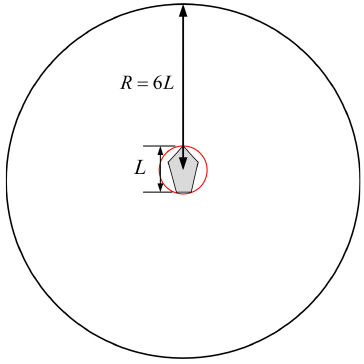
Figure 4. Ship avoidance